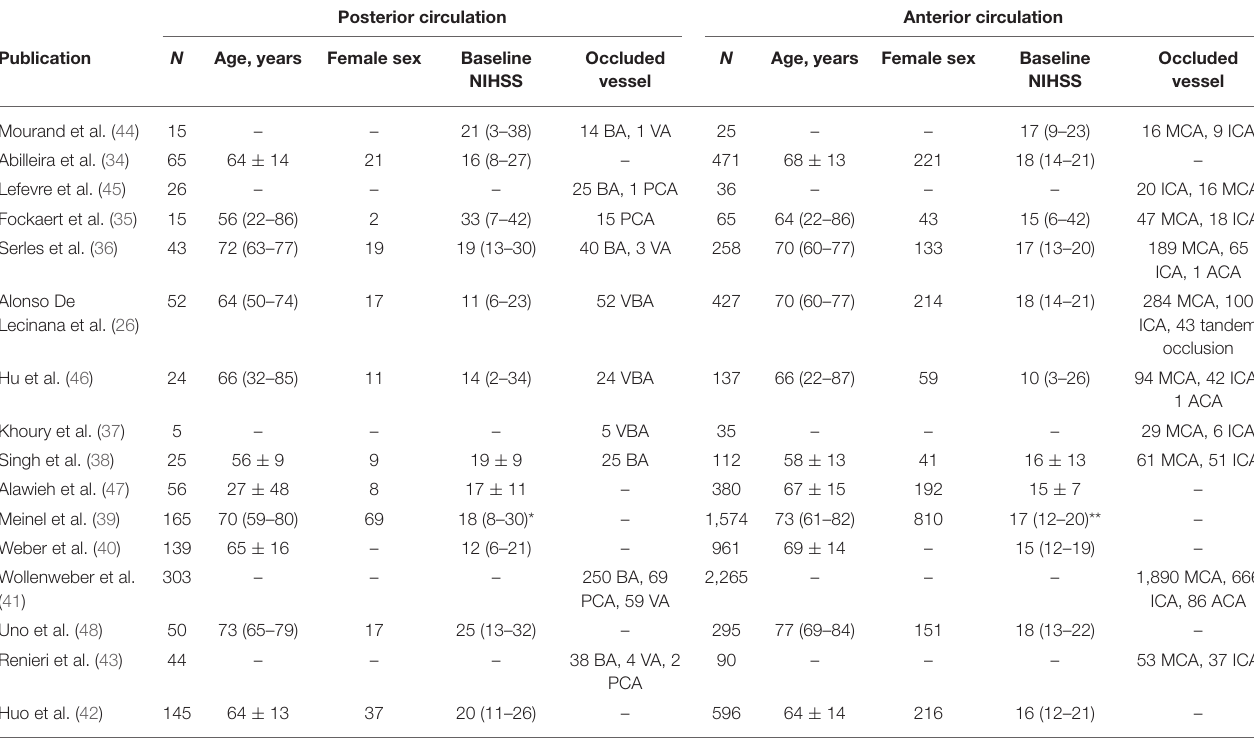
TABLE 1 | Baseline characteristics reported in included studies.